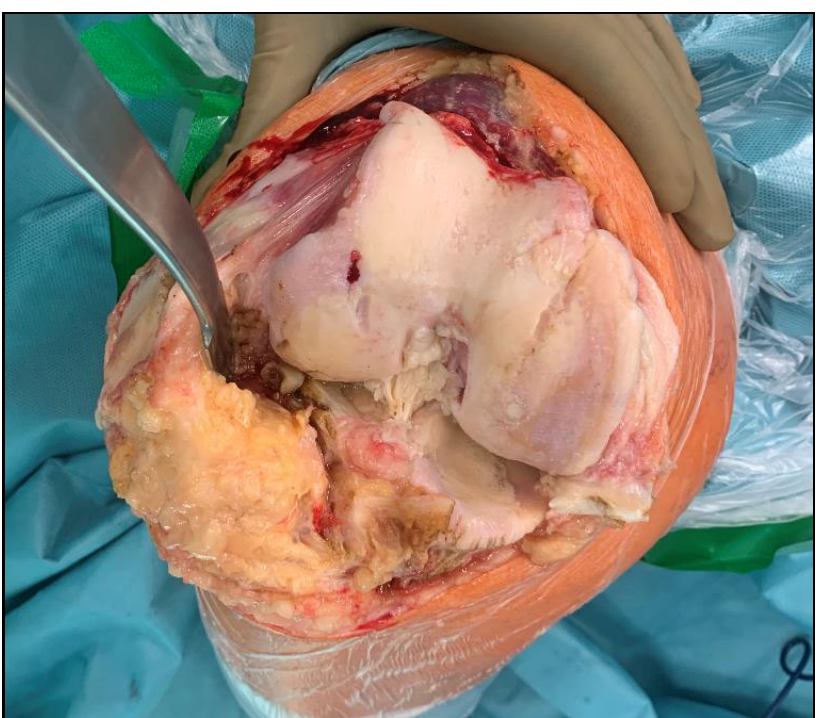
Figure 1. Osteoarthritis of the knee joint; in the upper part of the figure, femoral condyles are seen with major osteoarthritic changes. In the lower part, the tibial plateau (partially) is seen. Source: proprietary material, intraoperative photograph.